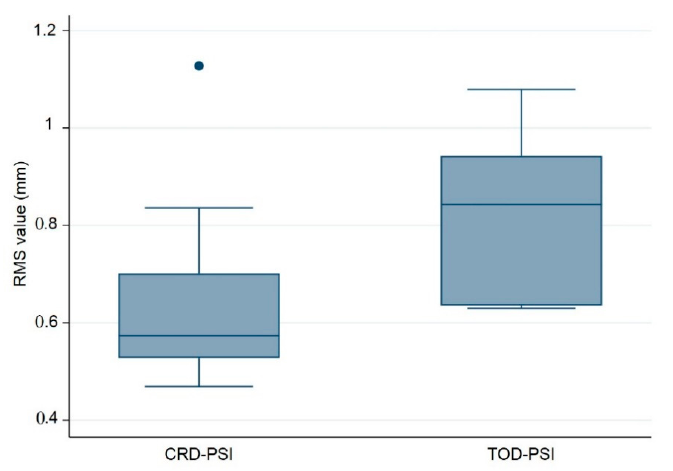
Figure 5. Box plot illustrating the accuracy comparison with respect to the root mean square (RMS) values (mm) between the polymethylmethacrylate (PMMA) CRD-PSI and TOD-PSI test groups ( ● describes the statistical outlier, CRD-PSI 01).